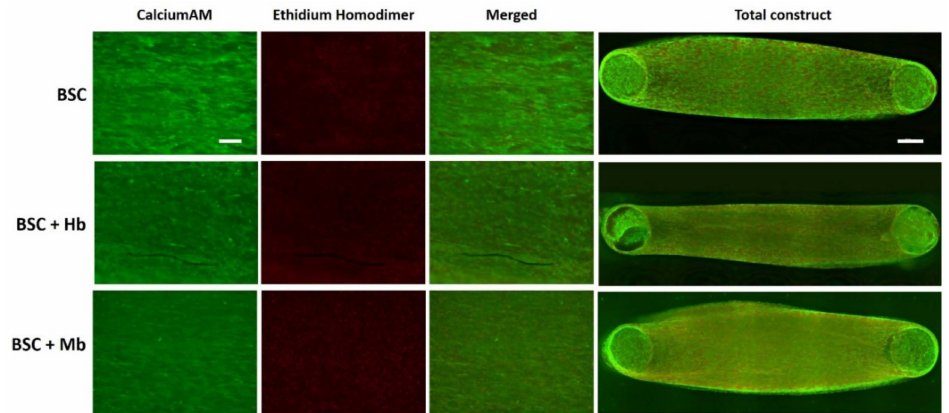
Figure 5. Live–dead staining of muscle constructs. BAMs generated from BSC, BSC + Hb, or BSC + Mb (3 mg / mL for both heme proteins) were stained with calcein AM (live cells, green) and ethidium homodimer (dead cells, red), to observe overall cell viability. Images were taken in green channel (488 nm) and red channel (594 nm), under identical microscope conditions, with z-Stack. For visualization of overall cell viability in total construct, x-y-stitching was performed. Scale bar in single channel images is 200 µ m, and scale bar in the total construct is 1000 µ